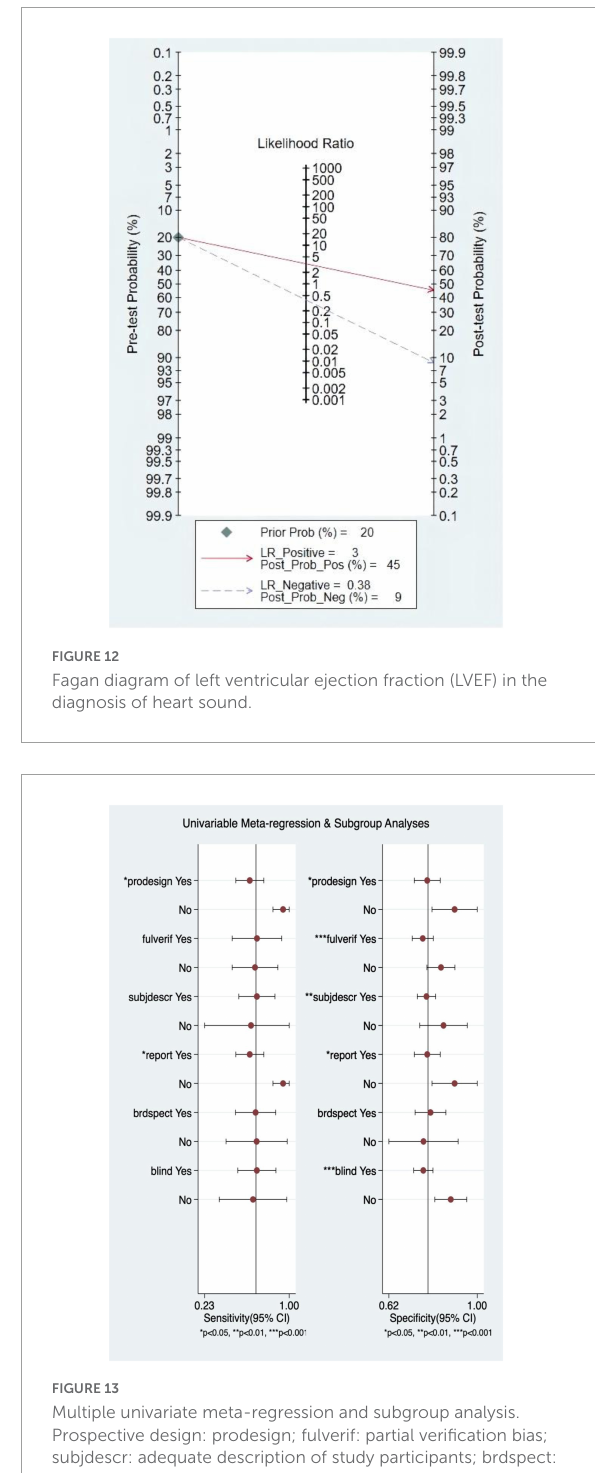
FIGURE13 Multiple univariate meta-regression and subgroup analysis. Prospective design: prodesign; fulverif: partial verification bias; subjdescr: adequate description of study participants; brdspect: broad spectrum of